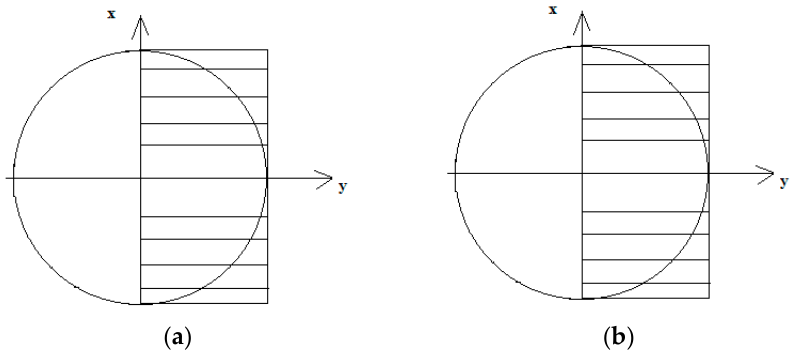
Figure 1. The distribution of ( a ) 𝜀 strains and ( b ) σ stresses under tension–compression.